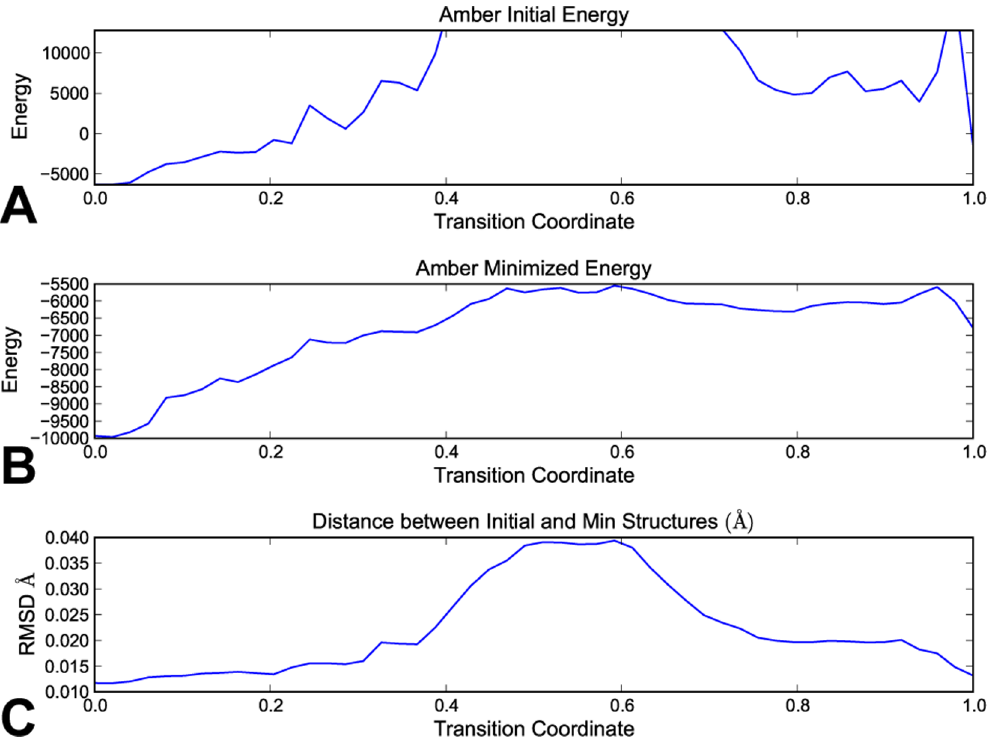
for the raw output of the automatically guided run (B) Amber energies after 100 rounds of minimization (C) Distance between raw output and minimized structure. All structures are determined to be of low energy, post-minimization, according to the Amber forcefield, with only mild (much less than 0.1A˚ full-atom RMSD ) differences between the two structures.